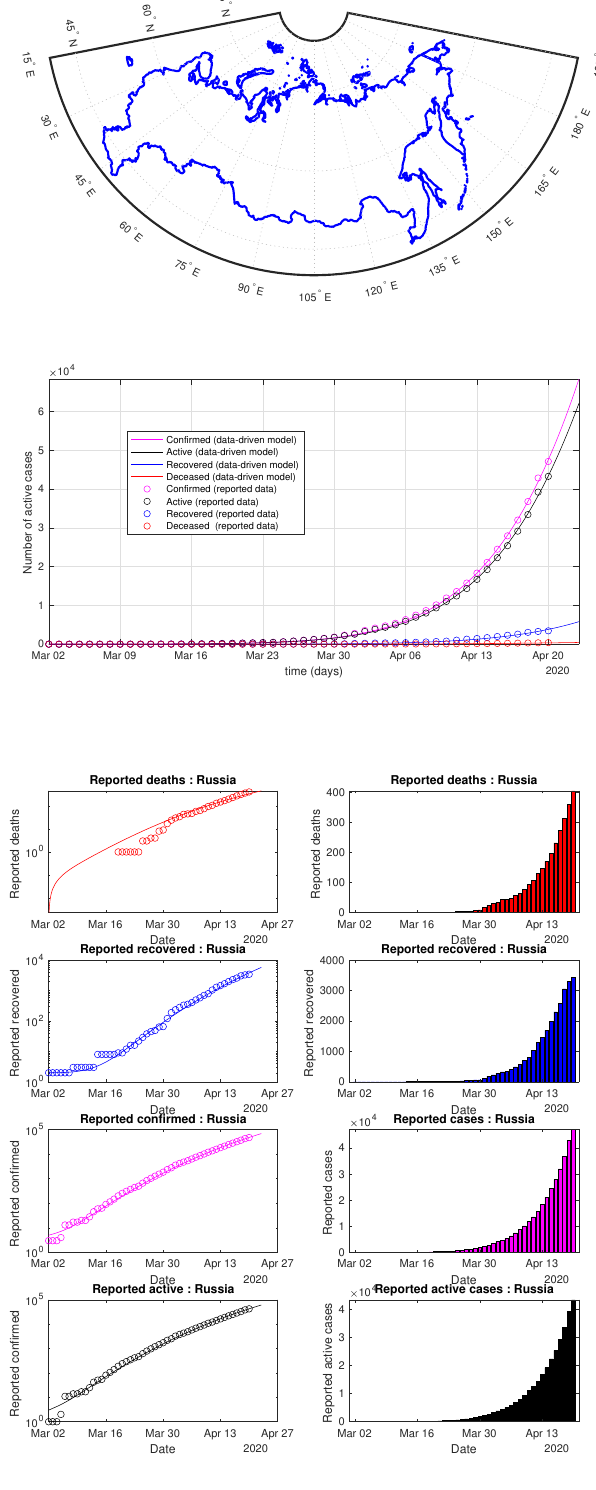
Figure 43. Russia: data of active, recovered, deceased (in circle or bar) vs. model of active, recovered, deceased over time. Tracking the number of active cases. Predictive analytics for the next couple